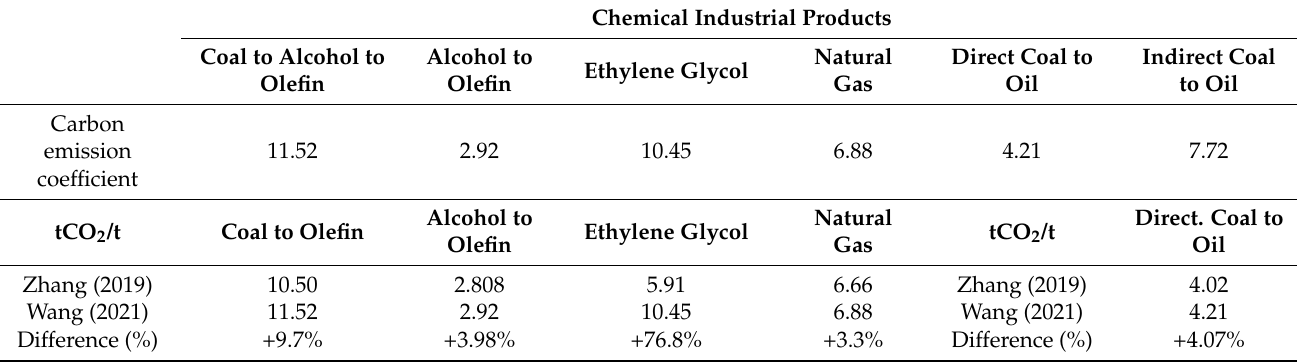
Table 2. Carbon emission coefficients of chemical industry products (tCO 2